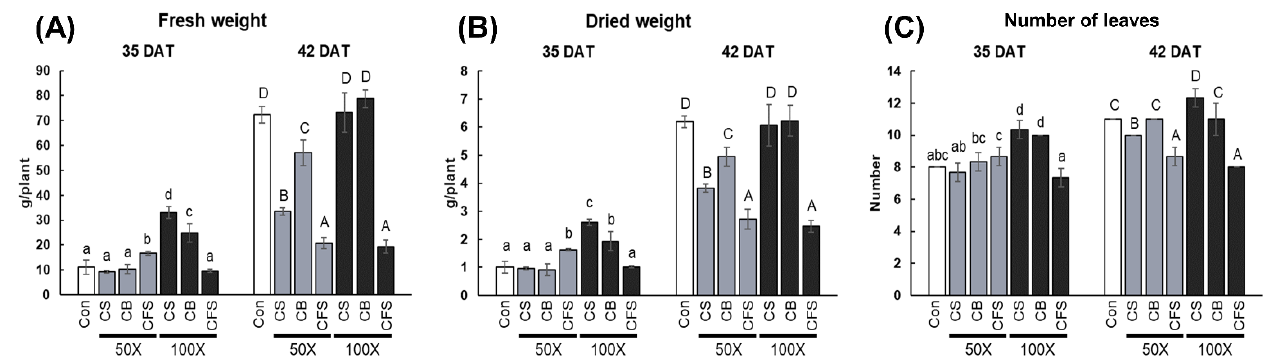
Figure 3. Growth indicators including ( A ) fresh weight, ( B ) dried weight, and ( C ) number of leaves of kale treated different Chlorella treatments and concentrations. Kale grown in the greenhouse under Chlorella treatments with 50 and 100-fold dilutions. Bars represent the mean ± SD of three replicates. Different letters indicate significant differences at p < 0.05 based on Duncan’s multiple range tests. Con, distilled water; CS, Chlorella suspension; CB, Chlorella biomass; and CFS, Chlorella − free supernatant.